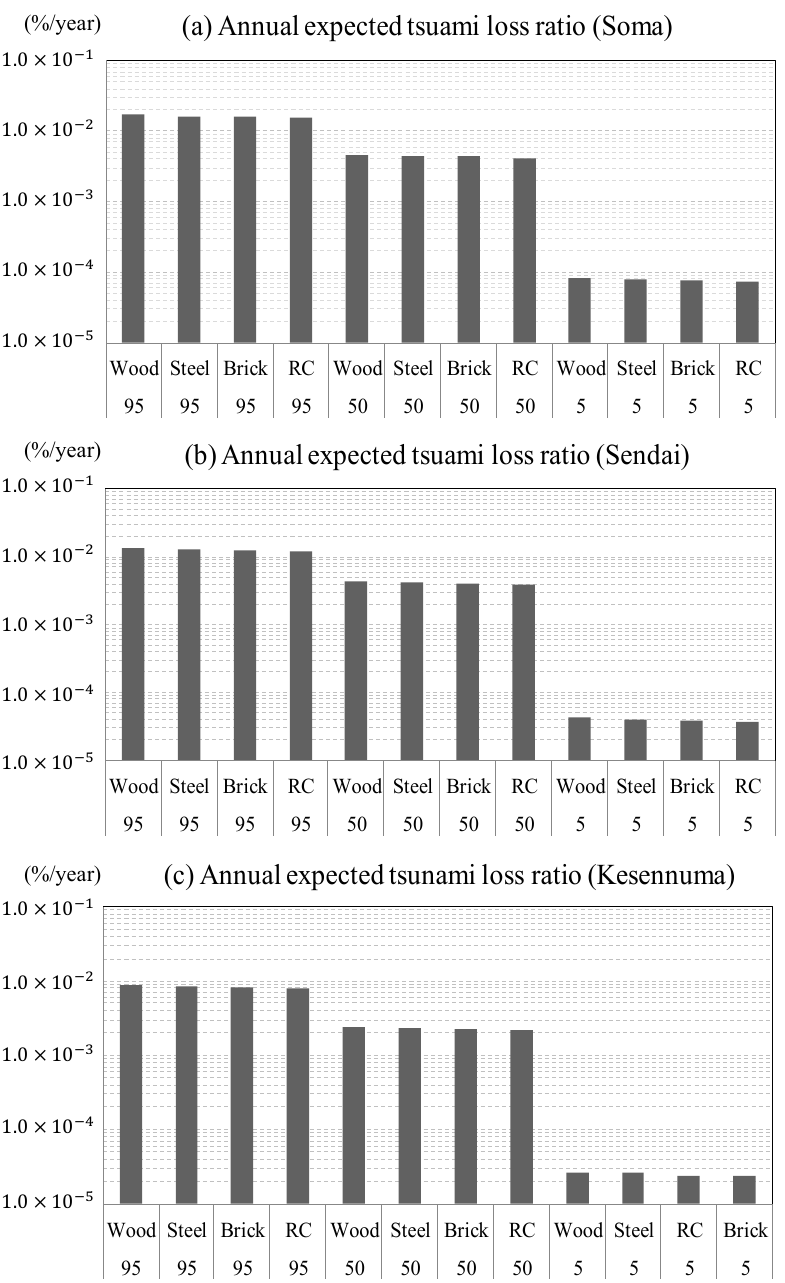
Figure 16. Expected value of the tsunami risk at each risk assessment point (( a ) Soma; ( b ) Sendai; and ( c ) Kesennuma) according to the structure (upper horizontal axis) and the percentile value of the tsunami hazard (lower horizontal axis).